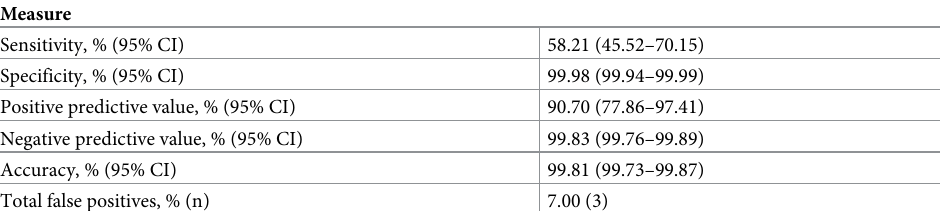
Table 2. Evaluation of sensitivity, specificity, and positive and negative predictive values of health information exchange data in identifying confirmed cases of microcephaly—New York City, January 1, 2013–December 31, 2015 a .